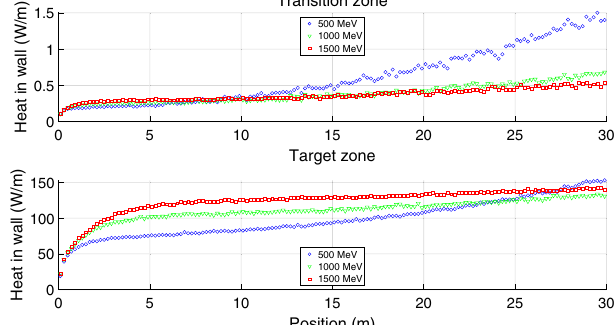
FIG. 15. Power loss on the beam tube for different energies in transition and target zone.